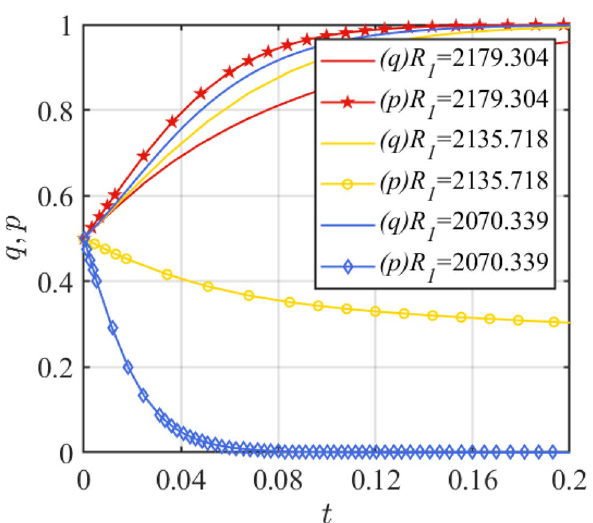
Figure 8. Effect of parameter R 1